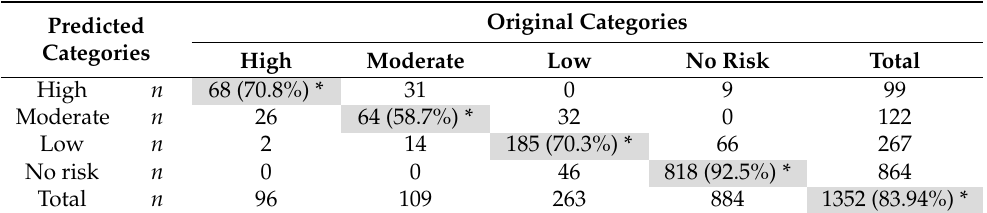
Table 5. Concordance Index between original and predicted Braden index categories.